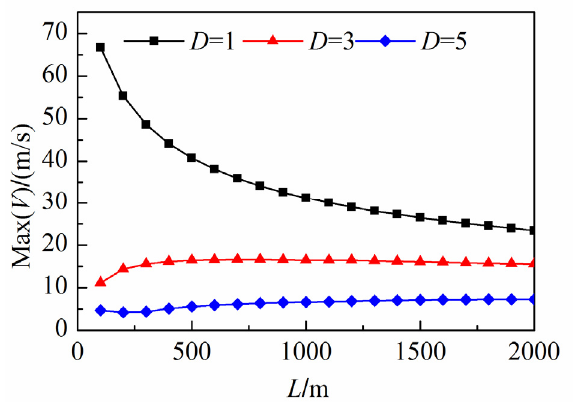
Figure 27. Effect of duct lengths and diameters on gas pressure.